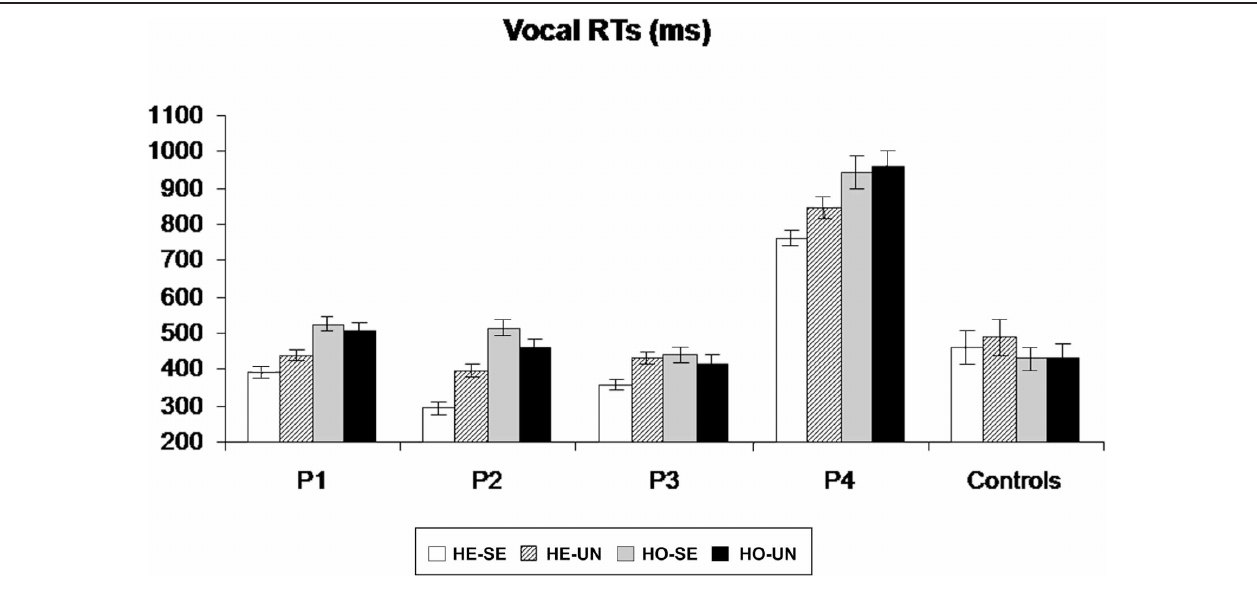
FIGURE 3 | Mean (and standard errors) vocal RTs to left-sided tactile stimuli for patients P1–P4, and for the control group, in the four experimental conditions, obtained by manipulating the